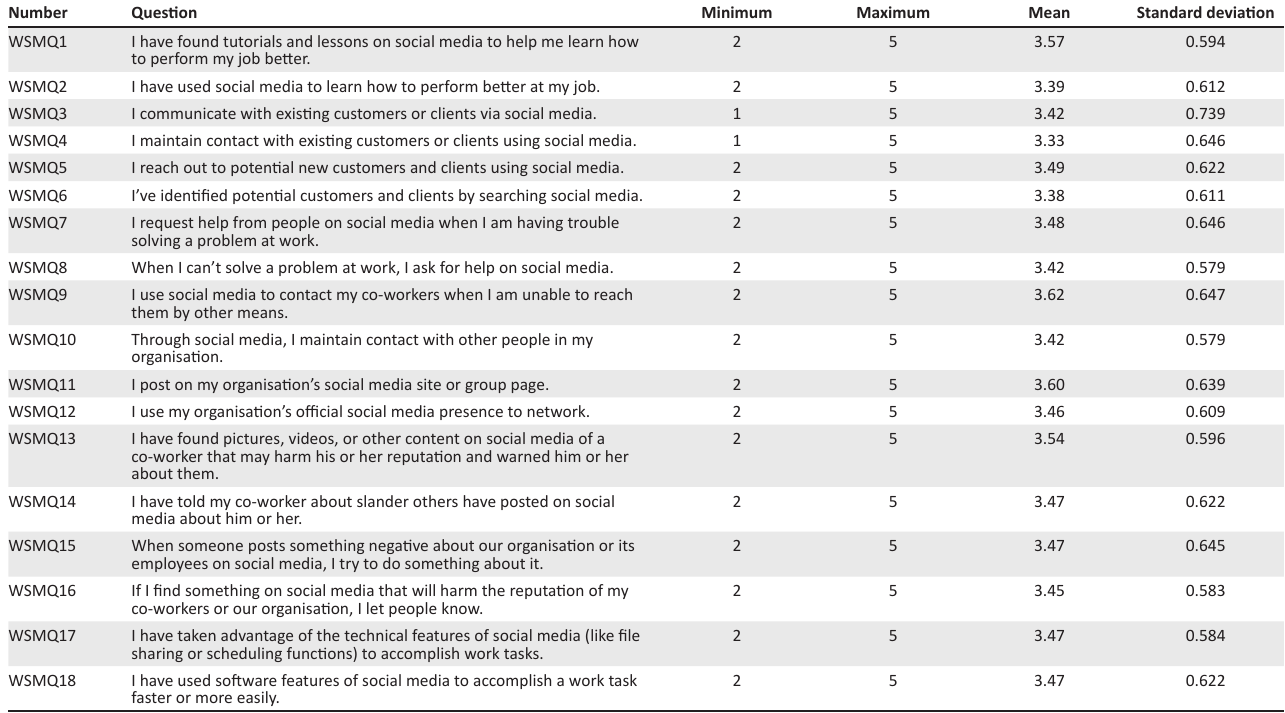
TABLE 2: Descriptive statistics for Work-related Social Media Questionnaire results.